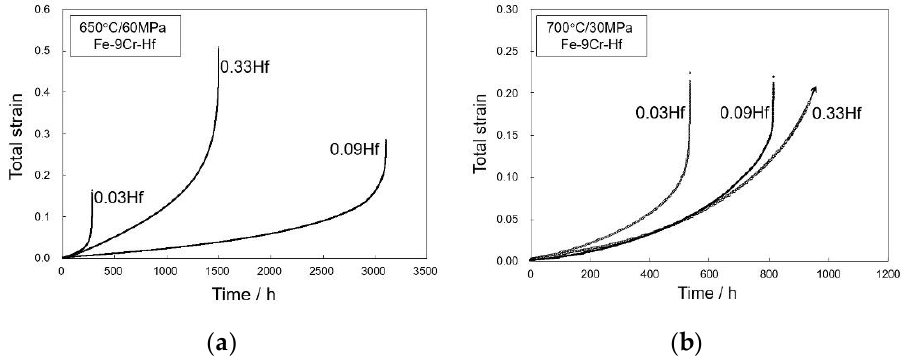
Figure 3. Creep curves of the alloys tested under creep conditions of ( a ) 650 °C/60 MPa [11] and ( b ) 700 °C/30 MPa.